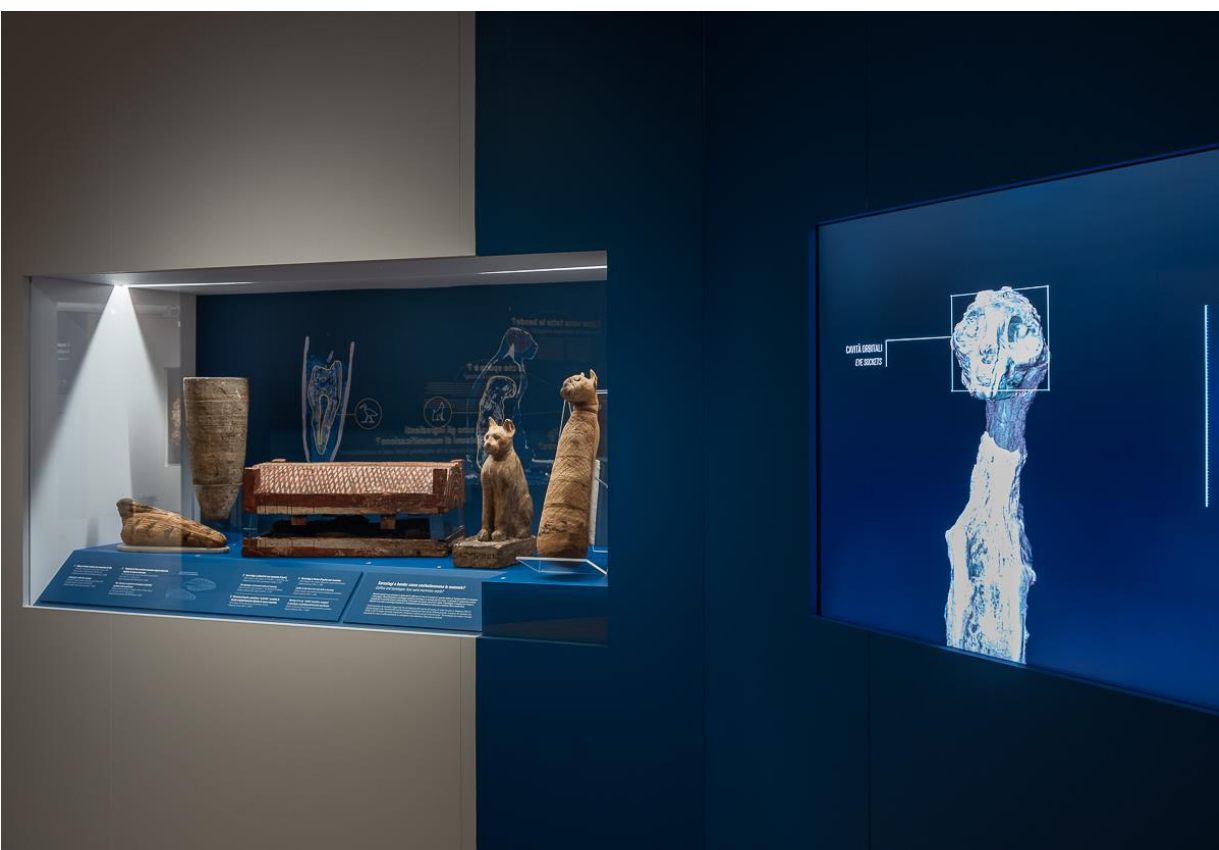
Figure 3. Different types of animal mummies and virtual unwrapping of a cat mummy (cat. 2348/1), from the exhibition Archeologia Invisibile, Museo Egizio, Torino, 2019 (photograph by Museo Egizio,